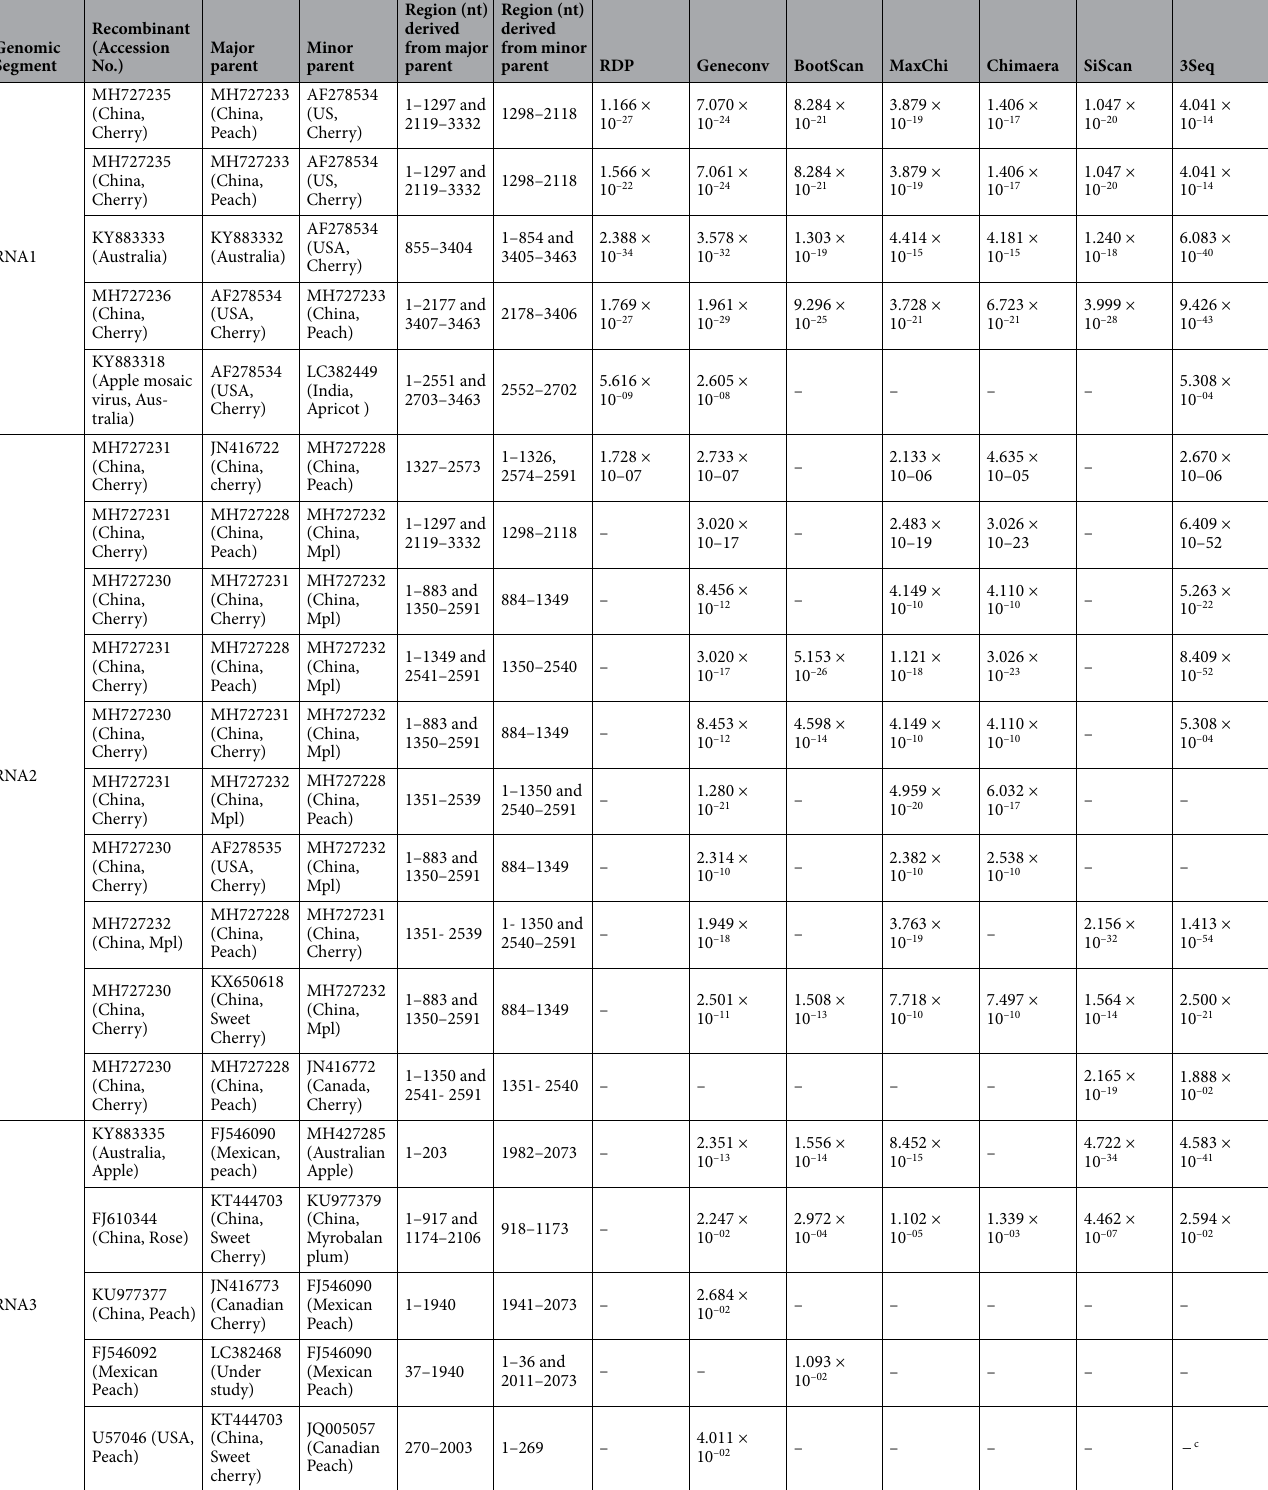
Table 3. Analysis of recombination events in PNRSV RNA1, RNA2 and RNA3 sequences under study compared with other genomic RNA1, RNA2 and RNA3 sequences from different geographical locations